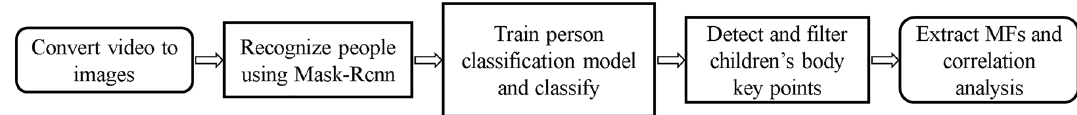
Figure 1. The overview of our research